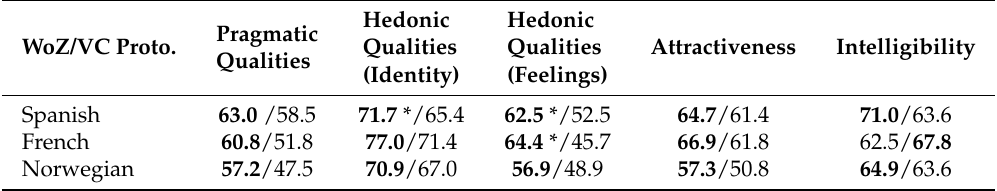
Table 12. VAAQ average score per subquestionnaire for WoZ experiments, and for the VC prototype. The mark * indicates statistical significance.